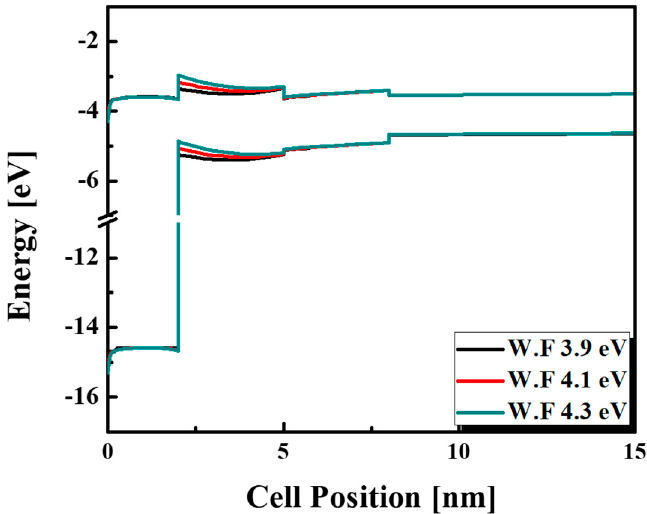
Figure 5. Band diagram of SHJ solar cells for various work functions of the LiF x layer .